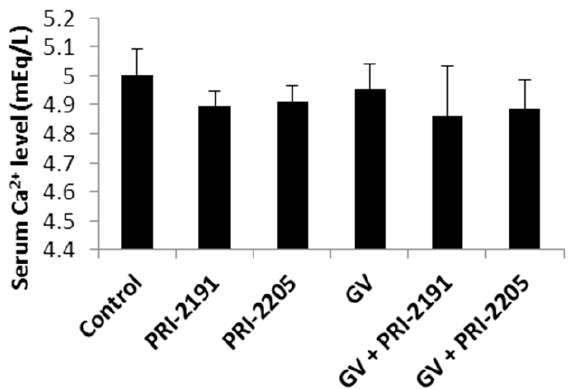
Figure 4. Calcium concentration (mean ± SD) in blood serum collected from mice bearing A549 tumors treated with PRI-2191 and PRI-2205 analogs alone or in combination with GV. GV, imatinib; PRI-2191 and PRI-2205, vitamin D analogs.